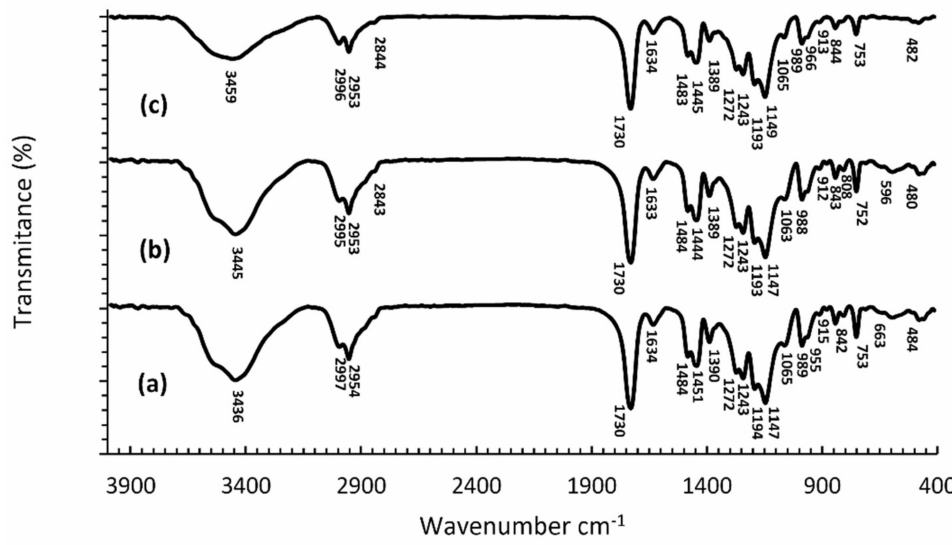
Figure 3. FTIR spectra of polymerized PMMA cold-curing ( a ), polymerized 10% AgNPs PMMA cold-curing ( b ), and ( c ) polymerized 10% AgCl PMMA cold-curing ( c